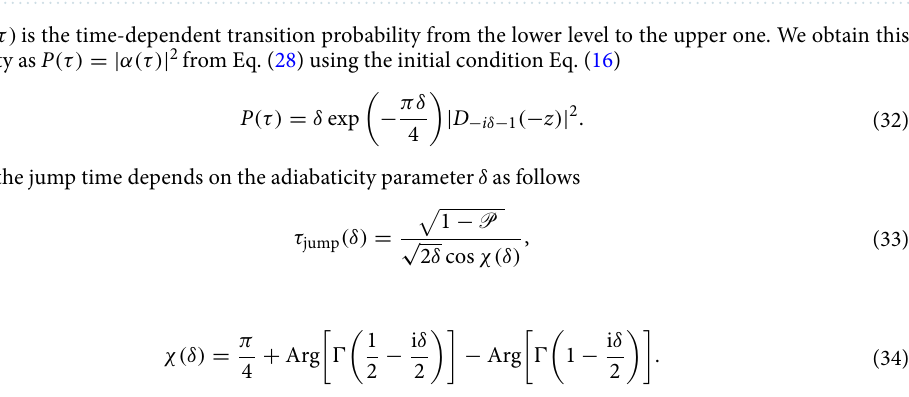
Figure 3. Comparison of the dynamics of the occupation probability versus time τ , obtained by Majorana’s method (blue curve) and Zener’s method (red curve). The left panels show the dynamics of the first component of the spinor α(τ) , while the right panels show the second component β(τ) , for three different values of the adiabaticity parameter δ . The yellow regions show the area where Majorana’s approach does not give the correct result because that method is asymptotic. The bright green horizontal dashed lines show the LZSM probability. These illustrate that far from the transition region both results, by Zener and Majorana, tend to that